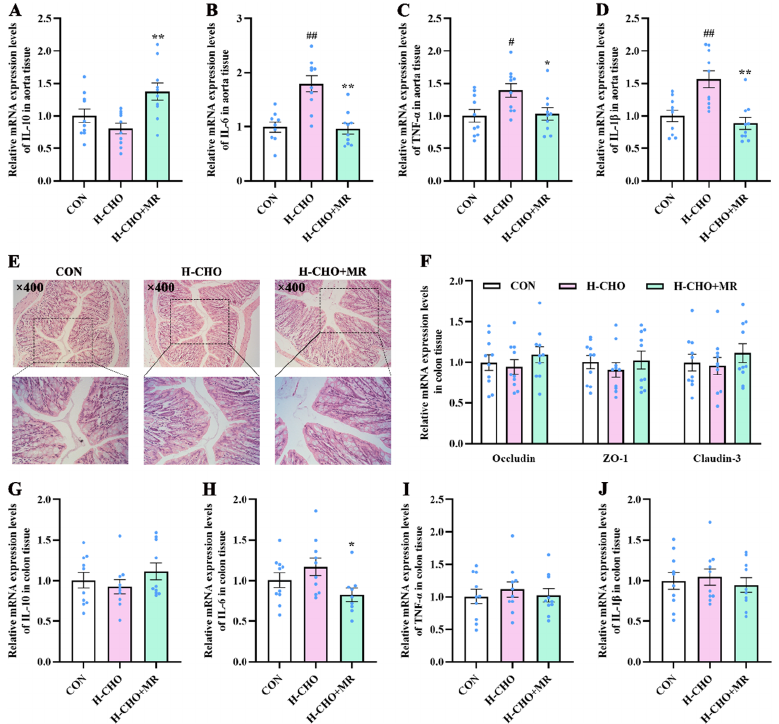
Figure 7. Effects of MR on mRNA expression levels of IL-10 ( A , G ), IL-6 ( B , H ), TNF- α ( C , I ), and IL-1 β ( D , J ) in the aorta tissue and colon tissue, respectively, and on the morphological structure of the colon (( E ), 400× magnification), as well as mRNA expression of Occludin , ZO-1 , Claudin-3 ( F ) in the colon of H-CHO mice. MR, methionine restriction; CON, normal diet group; H-CHO, high-choline diet group; H-CHO+MR, high-choline + methionine restricted diet group. # p < 0.05, ## p < 0.01 (H-CHO vs. CON); * p < 0.05, ** p < 0.01 (H-CHO+MR vs. H-CHO).